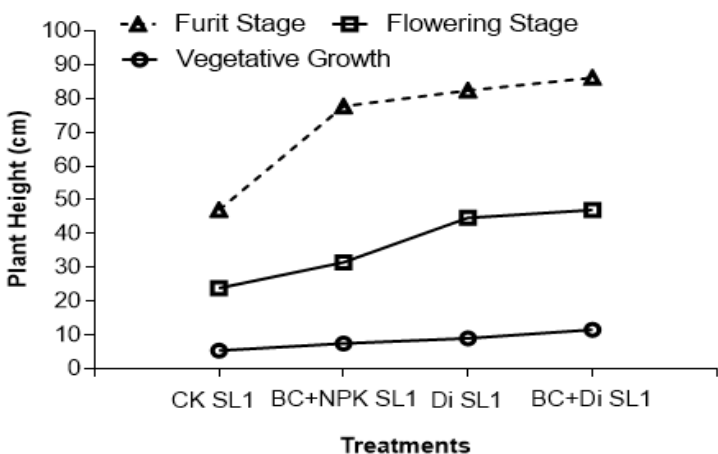
Figure 3. Effect of biochar and digestate treatments on Chinese melon height under saline irrigation water (SL1).